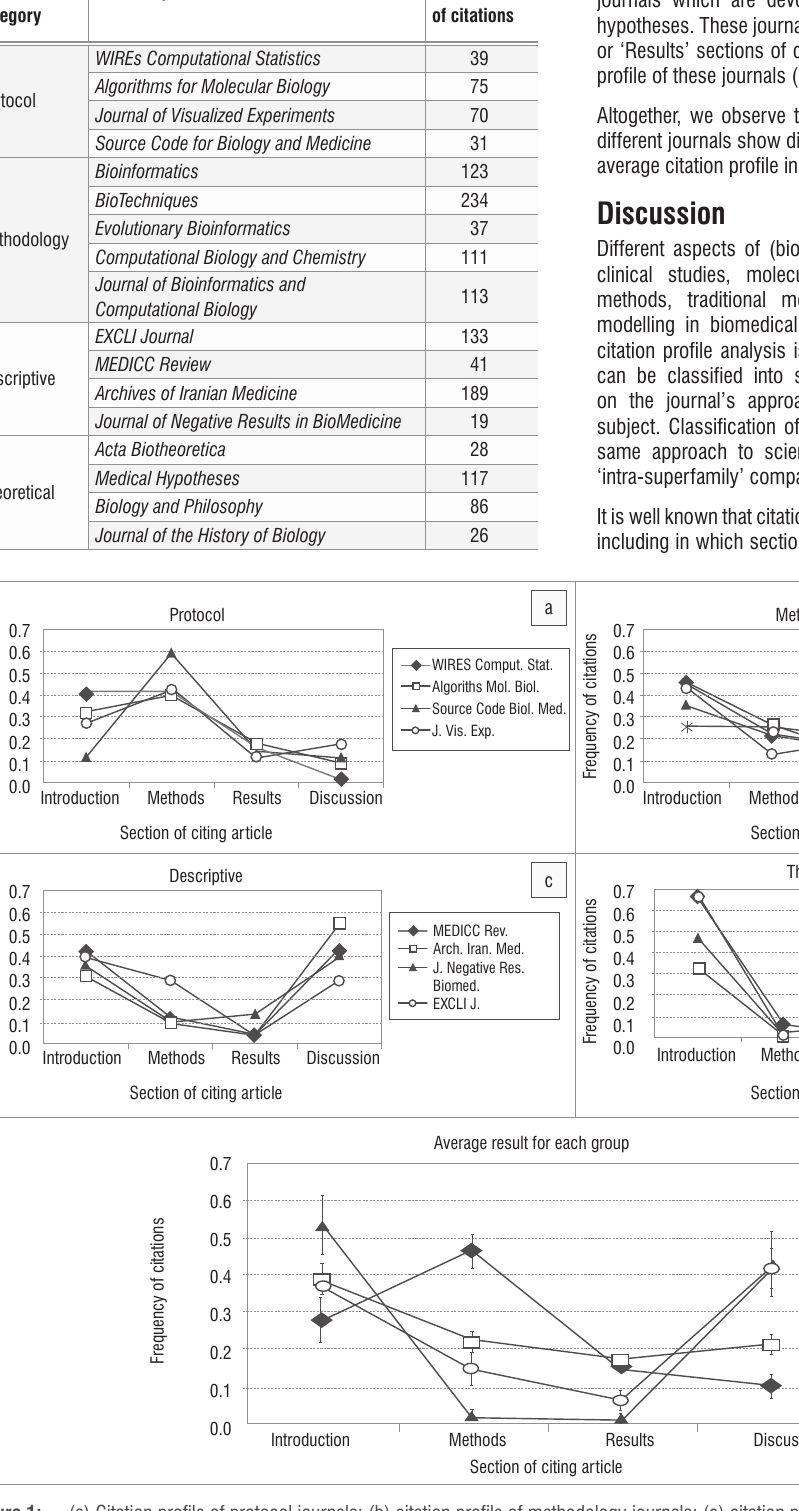
Figure 1: (a) Citation profile of protocol journals; (b) citation profile of methodology journals; (c) citation profile of descriptive journals; (d) citation profile of theoretical journals; and (e) average citation profile of each journal